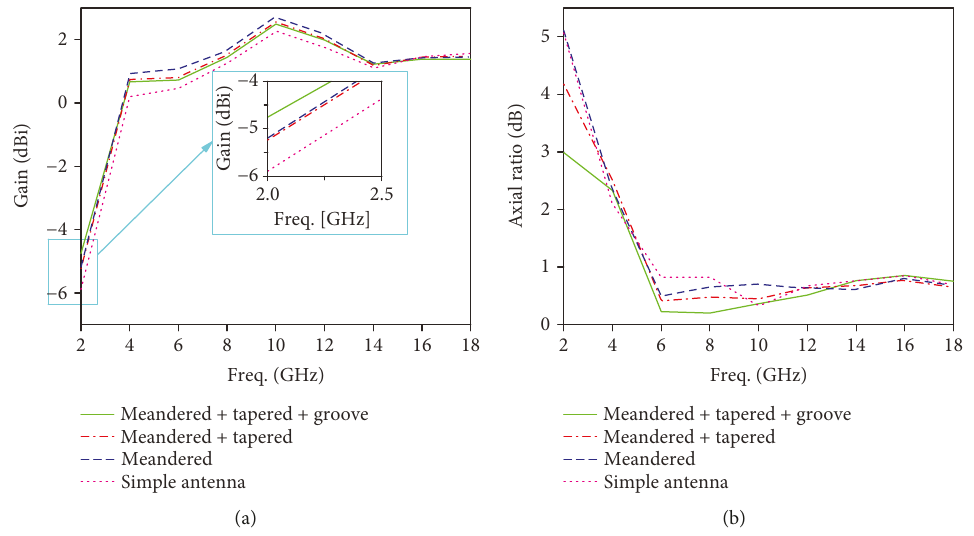
Figure 6: E ff ect of meandering, tapering, and groove on (a) gain and (b) axial